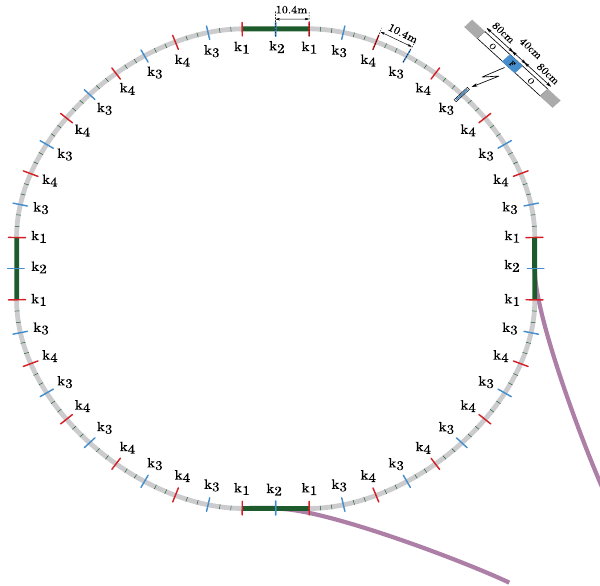
FIG. 1. A detail of the storage ring lattice is shown here with focusing and defocusing quadrupoles (shown as k 3 and k 4 ). The bending sections, including the short straight sections, have a length of 10.417 m, three sections assembled as one unit. The long straight sections are 20.834 m long with a quadrupole (shown as k 2 ) in the middle and two half-length quads (shown as k 1 ) at both ends. The values of the magnetic quadrupole strength are: k 1 ¼ 0 . 1 T = m, k 2 ¼ − 0 . 1 T = m, k 3 ¼ − 0 . 1 T = m, k 4 ¼ 0 . 1 T = m. The vertical tune, when running with these ¼ 0 . 67 , while the horizontal tune quadrupole strengths, is Q FIG. 3. The horizontal beta-function values around the ring for y ¼ 1 . 73 . CW and CCW is Q x